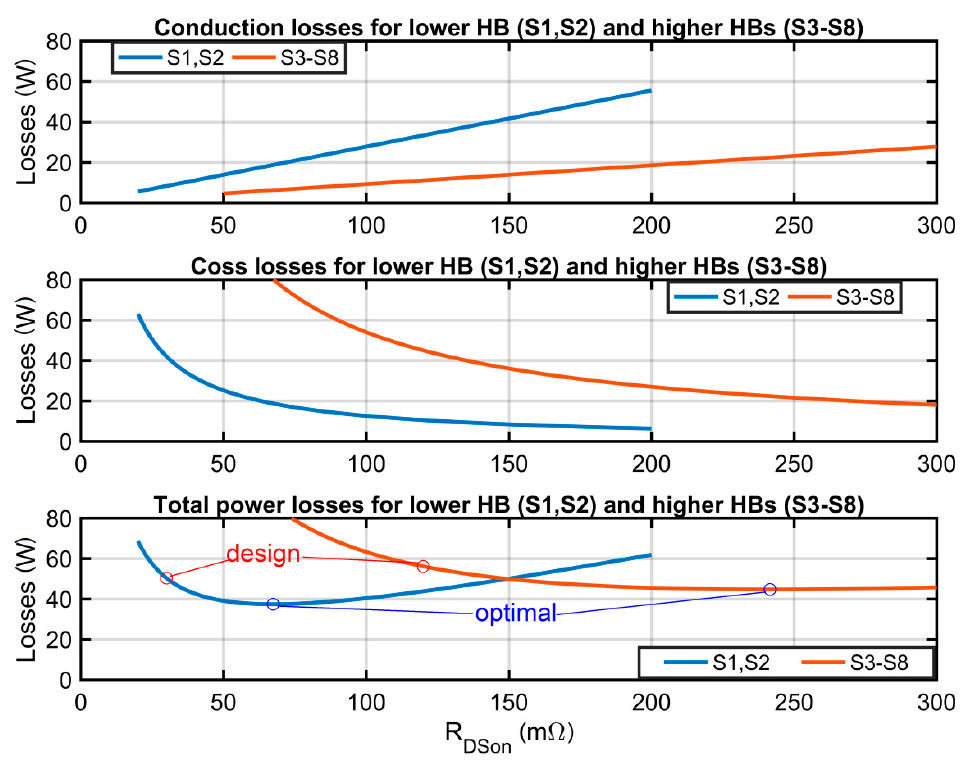
Figure 4. Results of the optimization of losses in power switches in terms of r DSon selection.